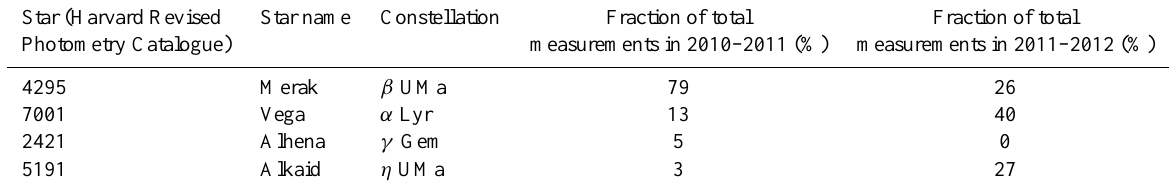
Table 2. Measurement stars most frequently used in polar winter star photometry data sets at Eureka in 2010–2011 and 2011–2012. Star (Harvard